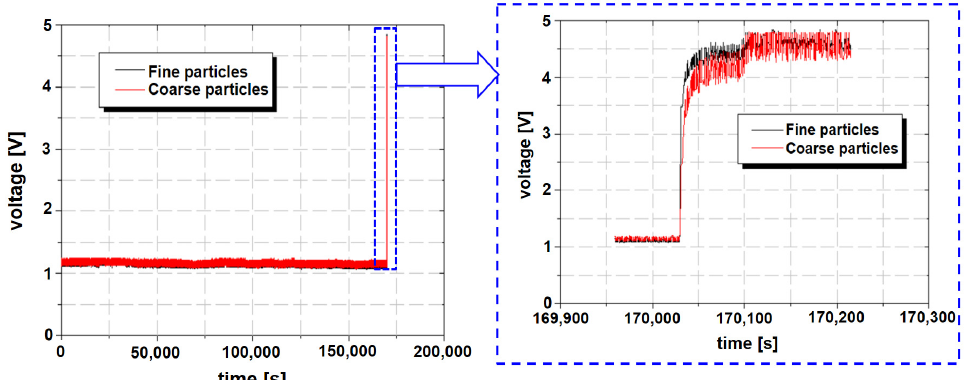
Figure 10. Measured voltage with time in the first case.